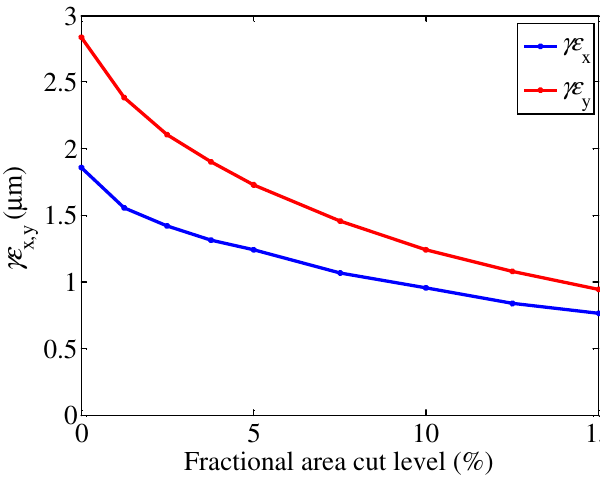
FIG. 33. (Color) Simulations of measured emittance, using the measured cathode emission and laser temporal profiles, as a function of the fractional area-cut levels. The bunch charge is 1 nC in this